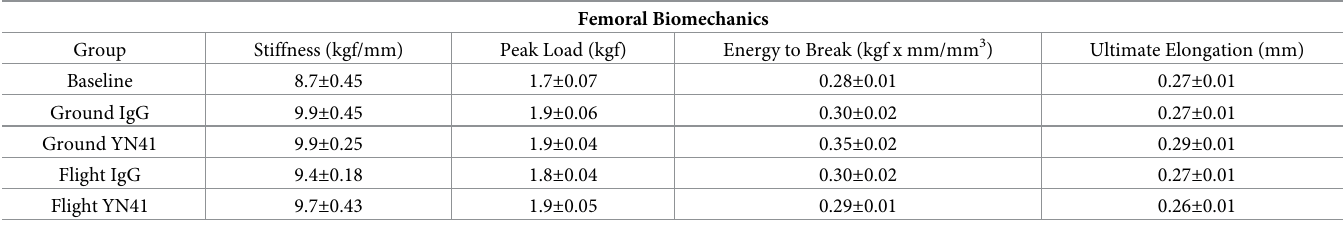
Table 3. Effect of microgravity and myostatin inhibition on femoral